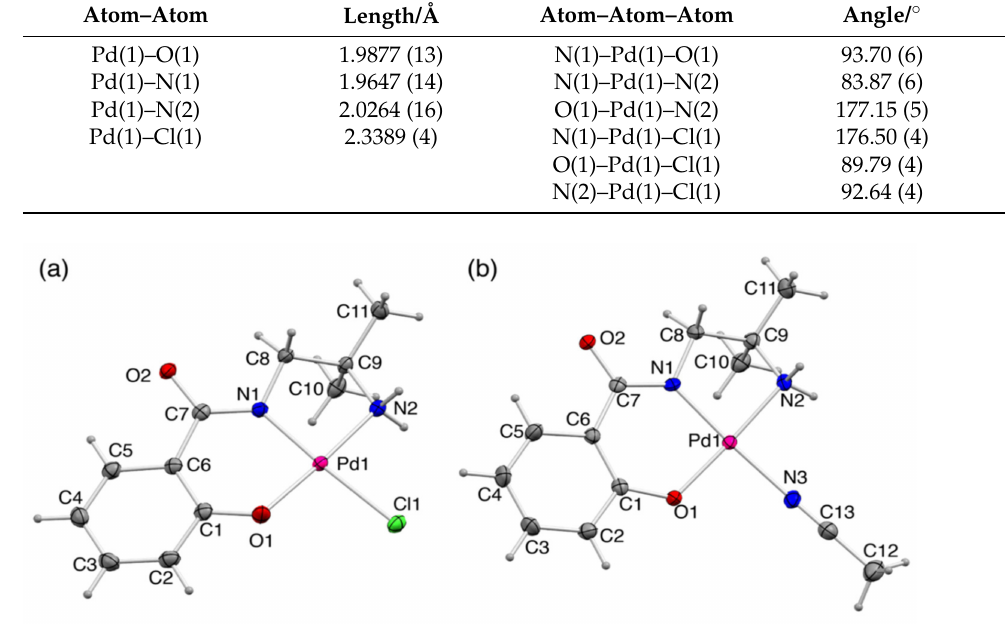
Figure 3. Perspective views of ( a ) [Pd(Amp)Cl] − in 1 , and ( b ) [Pd(Amp)(CH 3 CN)] in 1 (cid:48) (50% probability